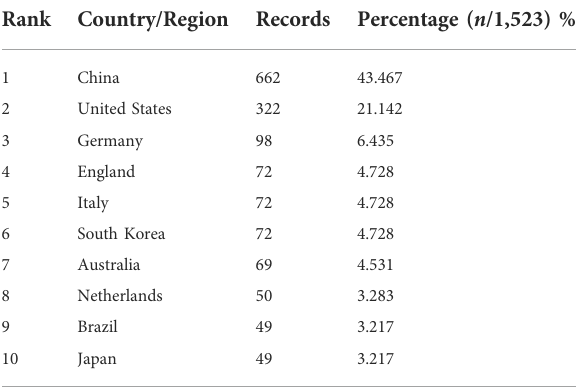
TABLE 1 The top 10 countries or regions of publications in biomaterials research in osteogenesis. Rank